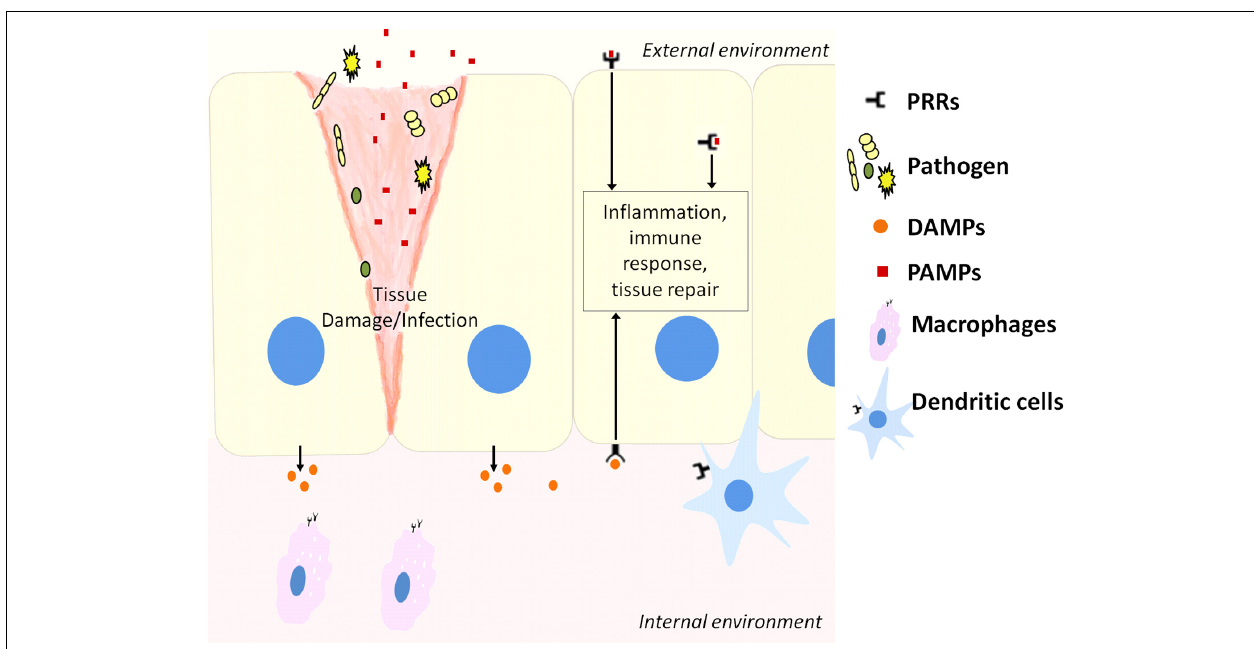
FIGURE 1 | Host cells including epithelial cells, macrophages, and dendritic cells contain pattern recognition receptors (PRRs) that can recognize molecules released from pathogens during infection (PAMPs) or stressed cells during tissue damage (DAMPs). This activates downstream pathways to resolve infection or repair damaged